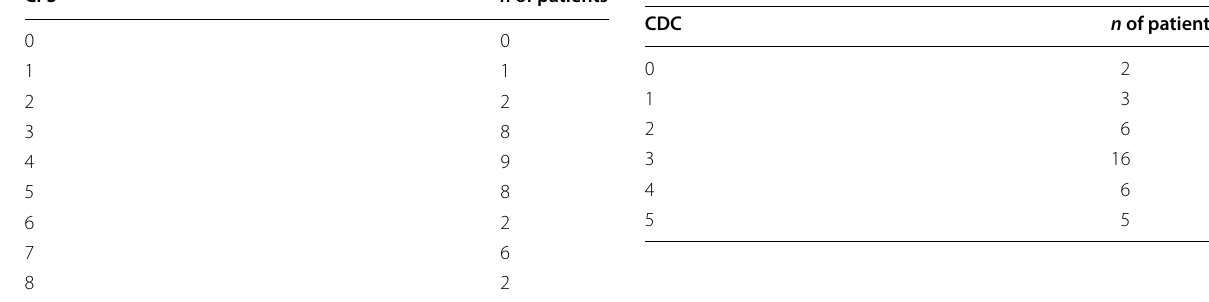
Table 3 Clinical Frailty Scale